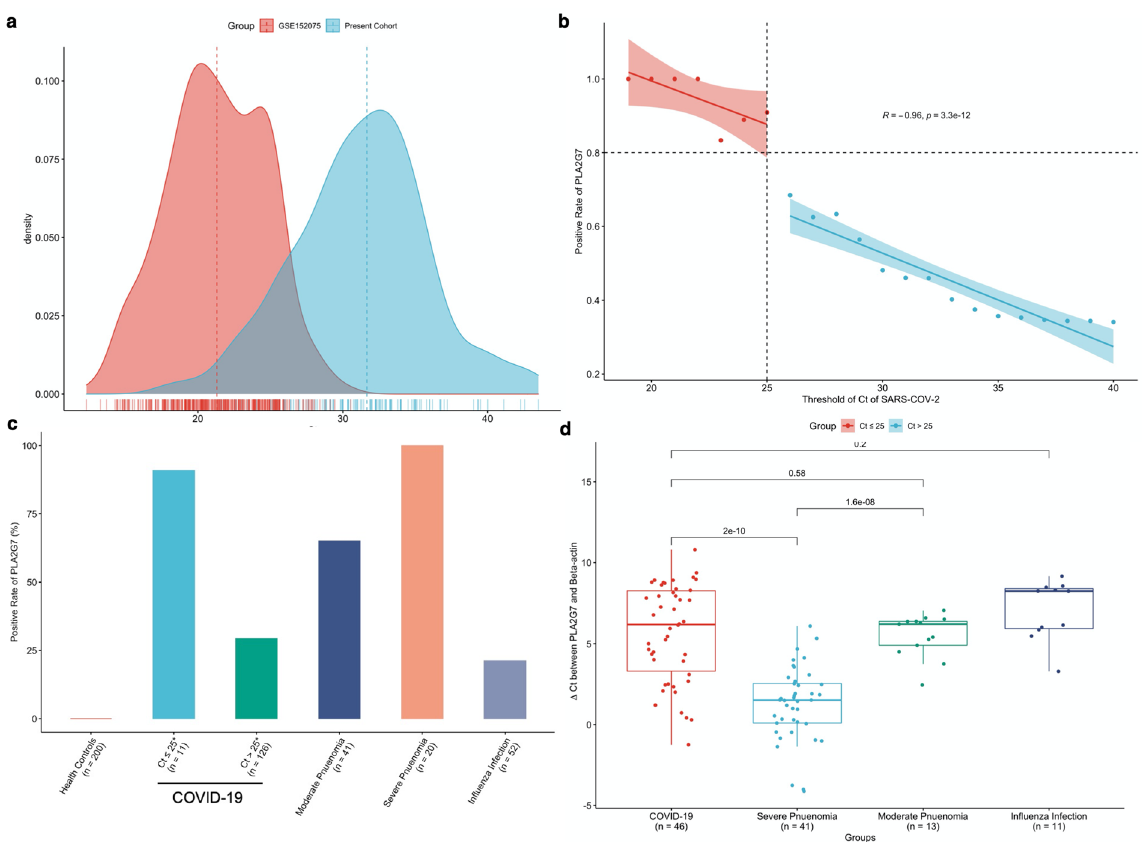
Figure 3. PLA2G7 was detected in a retrospective collection of nasal swabs from both COVID-19 and pneumonia patients. ( a ) Density plot of SARS-CoV-2 Ct values distribution in GSE152075 and present cohorts. ( b ) Relationship between the positive rate of PLA2G7 changed along with the Ct values of SARS-CoV-2. ( c ) Positive rates of PLA2G7 in patients’ group. (d) Comparison on the expression of PLA2G7 across samples was based on the ∆Ct which was defined as differences between Ct (PLA2G7) and Ct (ß-actin) (Fig. 3b), indicated that the positive rates of PLA2G7 was positively correlated with SRAS-CoV-2 viral load. It was worth of noting more than 80% PLA2G7 positive rates were observed in COVID-19 patients with Ct of SARS-CoV-2 ≤ 25 (Fig. 3b,c), which showed comparable diagnostic performance in GSE152075 as shown in Fig. 1e. The positive rates of PLA2G7 in all different groups were shown in Fig. 3c. There were no PLA2G7 positive cases in health controls. Among the 134 SARS-CoV-2 positive cases, 47 (35.1%) were PLA2G7 positive. It was worth of noting more than 90% PLA2G7 positive rates were observed in COVID-19 patients with Ct of SARS- CoV-2 ≤ 25 while 29.37% were seen in the group with Ct of SARS-CoV-2 > 25 (Fig. 3b,c). Surprisingly, a similar high detection rate of PLA2G7 was seen in patients with pneumonia (SRAS-CoV-2 negative). Notably, 100.00% of PLA2G7 positive rates were seen in group of severe pneumonia while 65.00% were noticed in moderate pneu- monia patients. Conversely, only about 20.00% PLA2G7 positive rates were observed in patients with influenza infection. To compare the expression of PLA2G7 across samples, ΔCt which was defined as differences between Ct (PLA2G7) and Ct (ß-actin) was applied. The ΔCt of PLA2G7 in group of SARS-CoV-2 shared a similar pattern to that in group of moderate pneumonia. Notably, ΔCt of PLA2G7 in group with severe pneumonia were lower than that in group with moderate pneumonia ( P value = 1.6e − 8), indicating PLA2G7 could be associated with the severity of pneumonia (Fig. 3d). Abnormal serum protein levels of PLA2G7 were examined in COVID‑19 patients. To under- stand the plasma levels of PLA2G7 which was also known as lipoprotein-associated phospholipase A 2 (Lp-PLA 2 ) in plasma 28 , a total of 117 serum samples (36 health controls, 81 COVID-19 patients) were collected. Among the 81 COVID-19 patients, 47 serum samples were collected at various time points from patients during the hos- pitalization (Hospitalization Group), 19 were from the patients who had been discharged and then re-positive but asymptomatic (Re-positive Group), and 15 were from fully recovered individuals (Recovered Group). Com- pared with the health controls, protein levels of Lp-PLA 2 were higher in hospitalization and re-positive patients (Fig. 4a). It was worth of noting that the hospitalization group showed significantly less levels of Lp-PLA 2 than that in re-positive group ( P value = 0.004). Thereafter, we sought to explore the trend of Lp-PLA 2 along with time among hospitalization group. The overall trend of Lp-PLA 2 in hospitalization group was reduced along with the